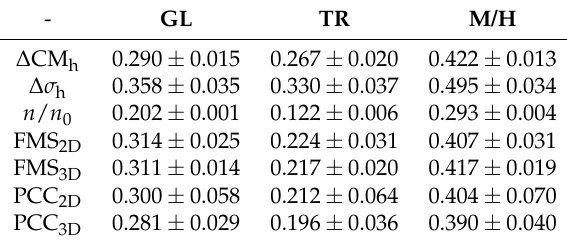
Figure 8. ( a ) The figure of merit in space FMS 3D between the BWCs and FWC depending on the time period ∆ t b of the backward simulation; ( b ) Pearson’s correlation coefficient PCC 3D between the BWCs and FWC. Mean values (diamonds), medians and lower and upper quartiles (boxes with horizontal lines) are indicated for the tropical region (TR, red), for mid- and high latitudes (M/H, blue) and for the globe (GL, black). Dashed lines indicate exponential fits to the mean values; the exponents are given in Table 2. Table 2. The exponent Λ (day − 1 ) and the error of the exponential fits to the curves ∆ CM h , ∆ σ h , n / n 0 , FMS 2D , FMS 3D , PCC 2D and PCC 3D versus ∆ t b for the globe (GL), for the tropical region (TR) and for mid- and high latitudes (M/H) in Figures 7 and